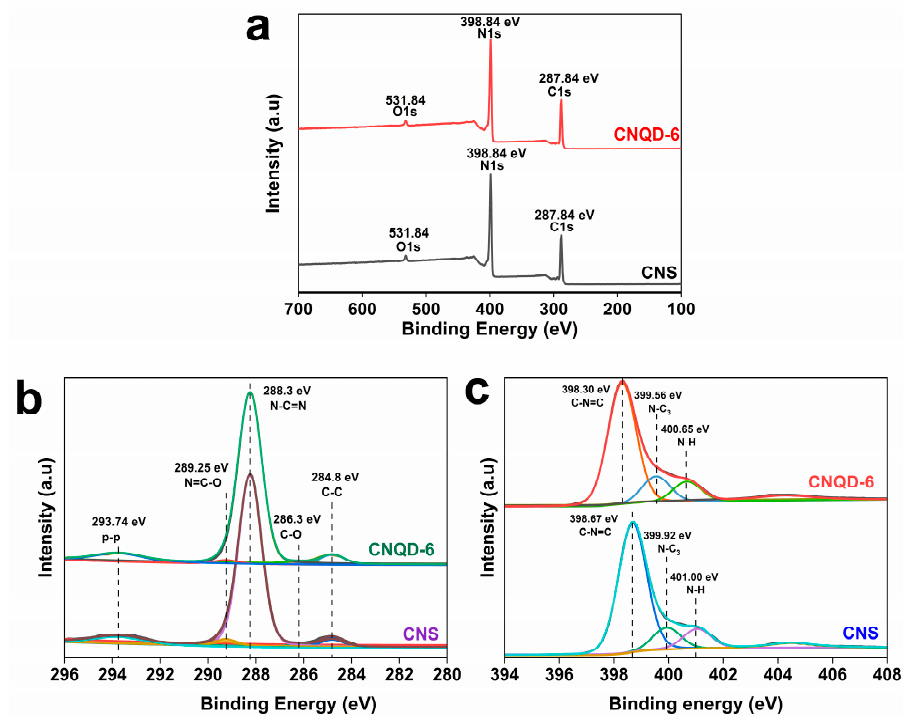
Figure 8. XPS spectra ( a ), C 1s spectral peak ( b ), and N 1s spectrum ( c ) of CNS and CNQD-6 photo- catalysts.